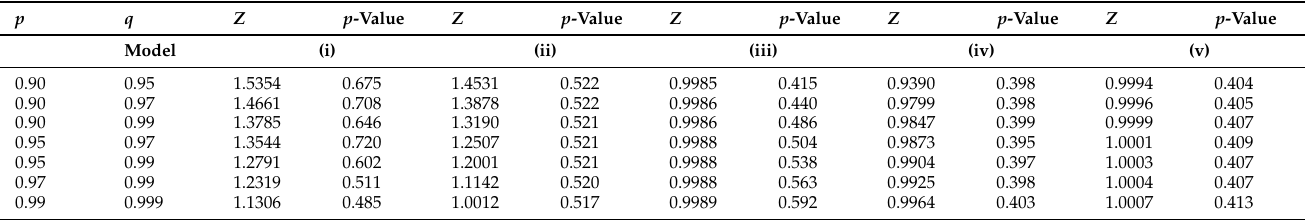
Table 3. Z and p -values obtained using the Acerbi and Szekely’s